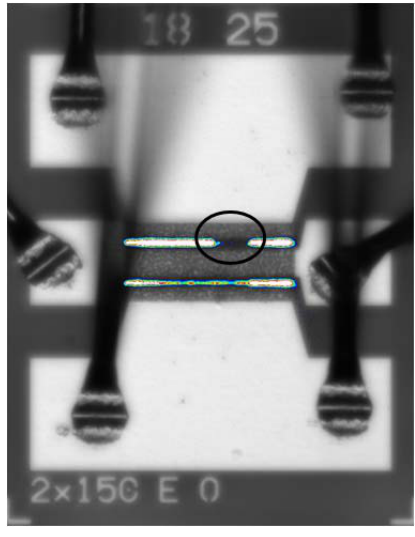
Figure 10. Electroluminescence of AlGaN/GaN HEMT after stress at V Class AB operation. Circled region indicates area of channel that has an increase in non-radiative trap formation after stress. Uniform EL emission during forward bias was observed prior to stress. Photoluminescence spectra were taken at the circled